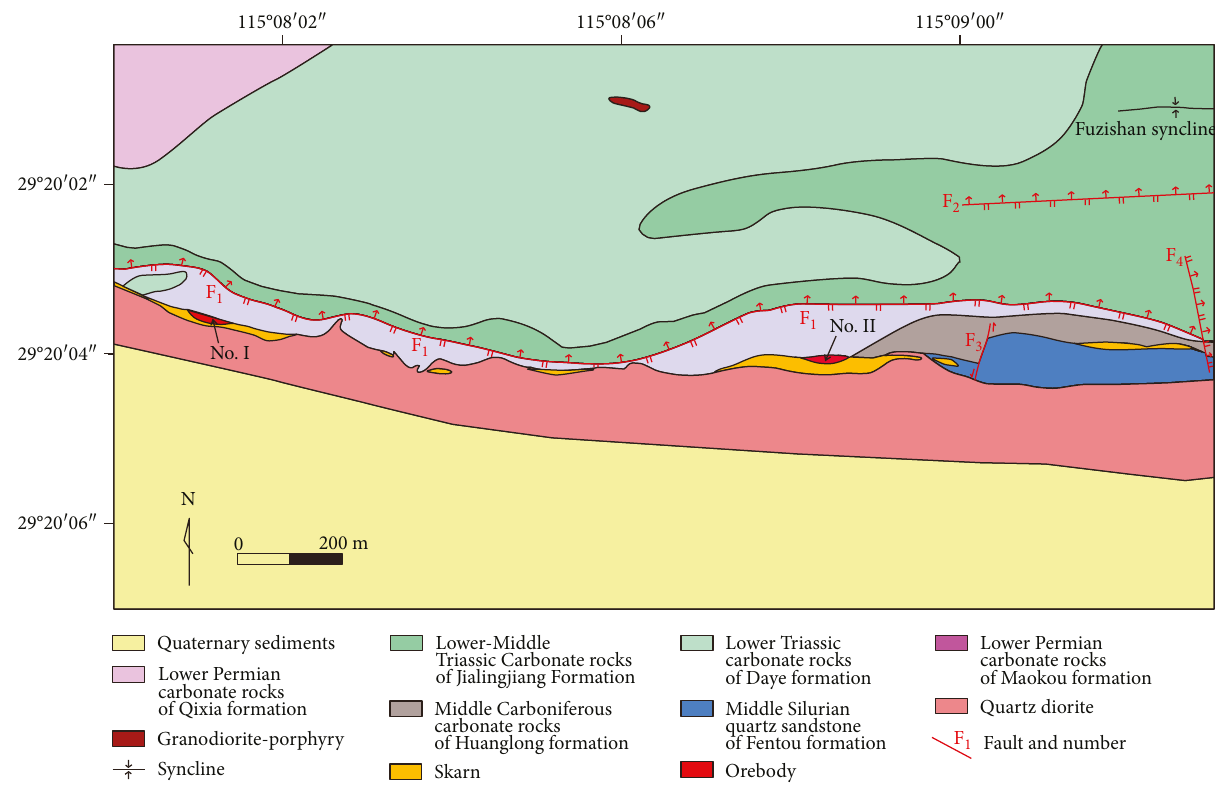
Figure 3: Simpli fi ed geological map of the Fuzishan Cu-Mo deposit (modi fi ed after